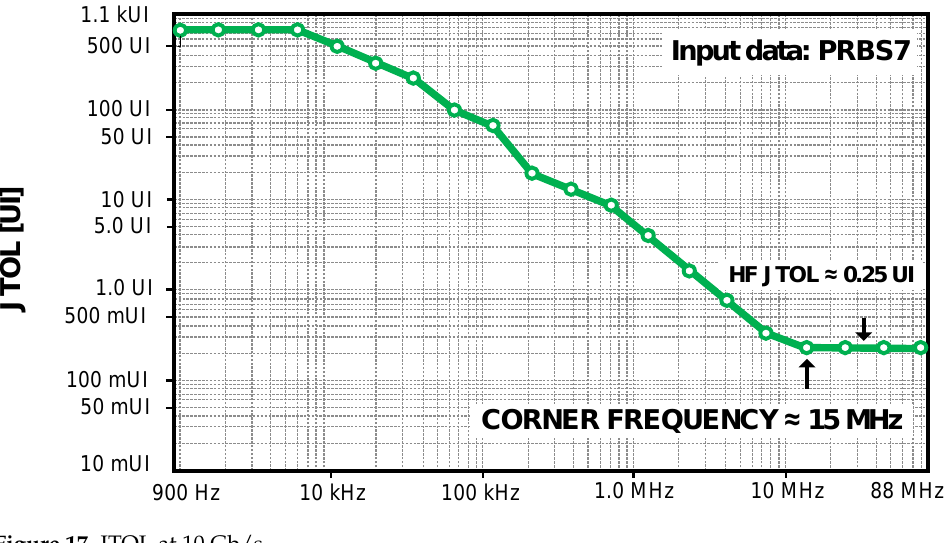
Figure 17. JTOL at 10 Gb/s. Table 1 summarizes the performance comparison of the proposed CDR with previously published digital CDRs. Table 1. Performance comparison with previous works.